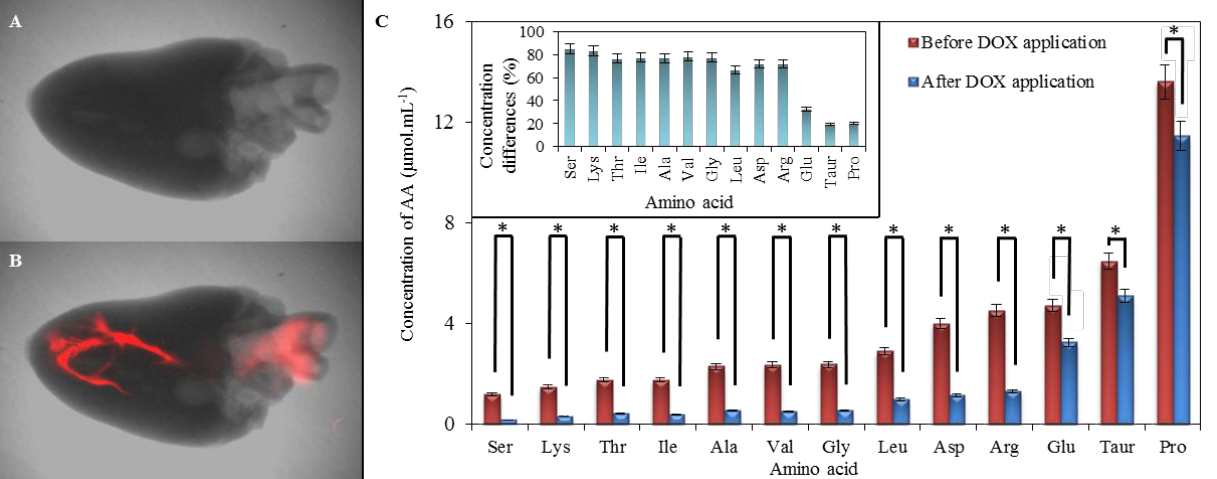
Figure 8. Comparison of chicken myocardium before and after application of 1000 μg mL −1 of doxorubicin dissolved in physiological saline solution. ( A ) Chicken cardiac muscle tissue without doxorubicin applied (X-ray image with overlaid fluorescence image); ( B ) Chicken cardiac muscle tissue with 50 μL of doxorubicin applied (X-ray image with overlaid fluorescence image). The fluorescence of doxorubicin was detected by Carestream In Vivo Xtreme Imaging System; ( C ) Expression of IELC results of myocardium amino acids content analysis. Both, control and heart, after application of doxorubicin were obtained as the averages from ten measurements. In inset it can be seen the percentage expression of differences between AA concentrations of amino acids in myocardium between and after application of DOX. * refer the differences between amino acid contents as statistically significant (at the p = 0.05